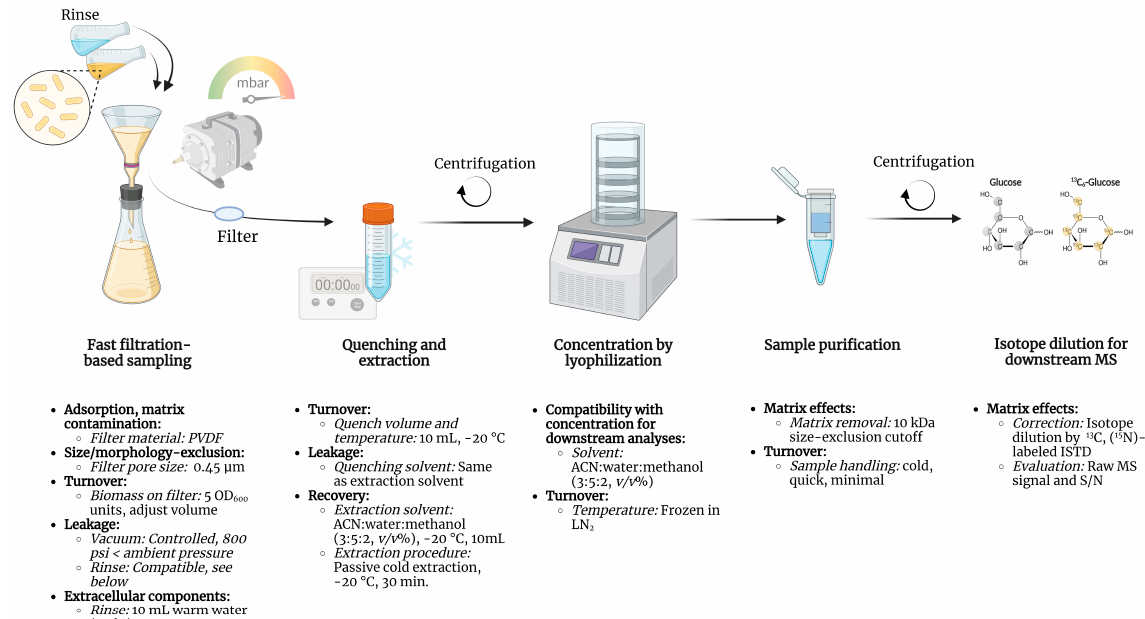
Figure 7. Simplified schematic of the optimized fast filtration sampling, quenching, extraction, and sample purification protocol for accurate, high-precision metabolic profiling of E. coli . Critical considerations (bold), parameters (italic), and recommended values, materials, and procedures discussed throughout this study are summarized in the lower panel. PVDF, polyvinylidene fluoride; ACN, acetonitrile; LN 2 , liquid nitrogen; ISTD, internal standard; MS, mass spectrometry; S/N, signal to